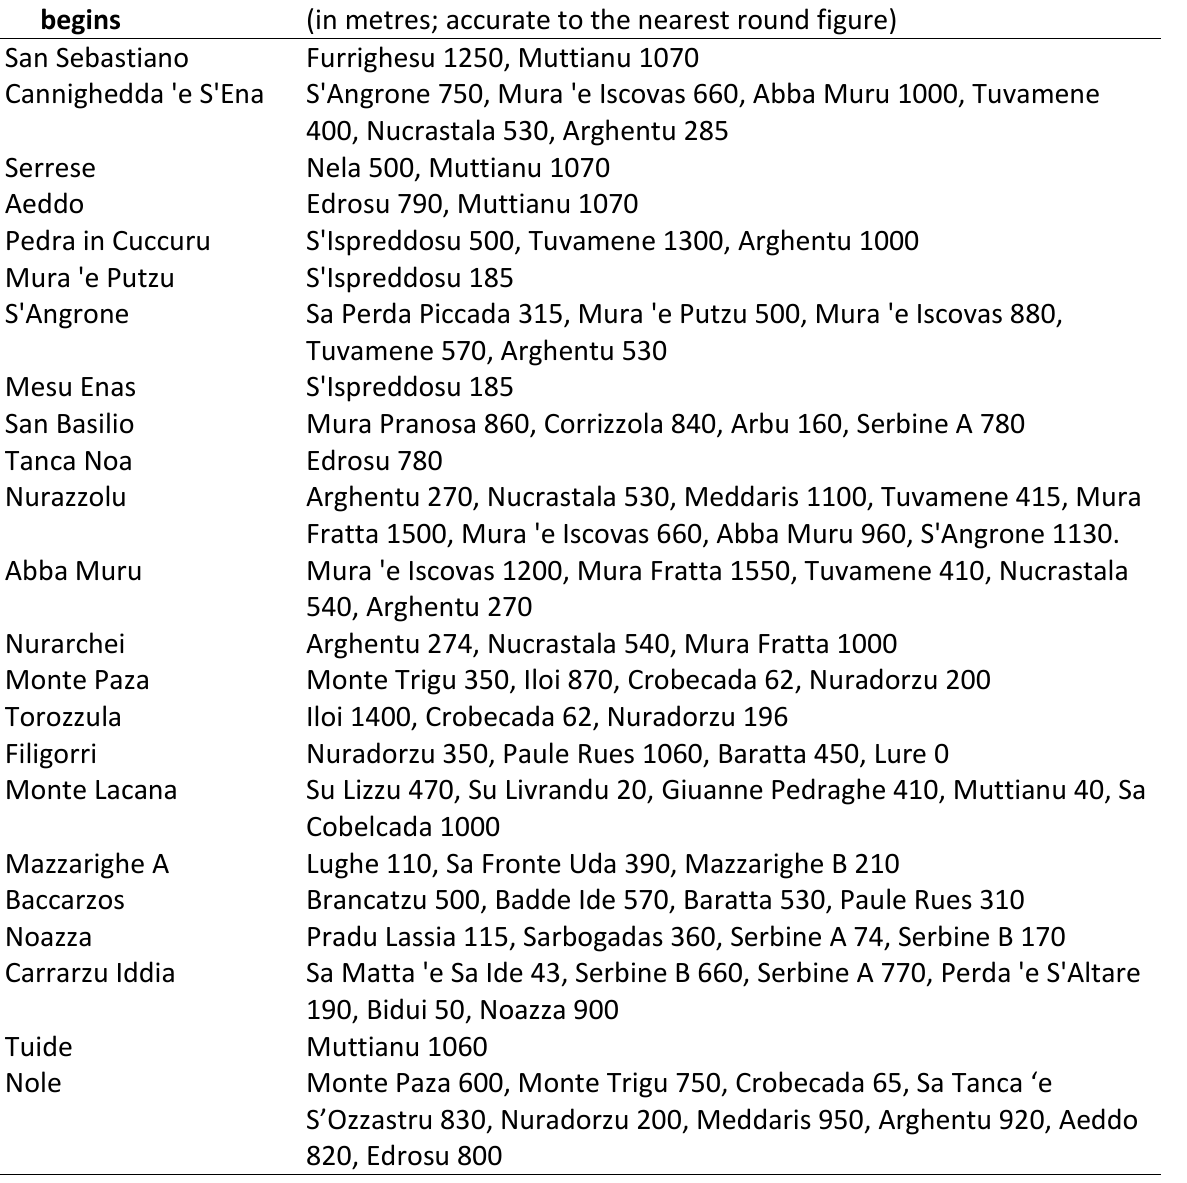
Table 1. Distances between Least-Cost Paths from peripheral dolmen towards median point. Dolmen where